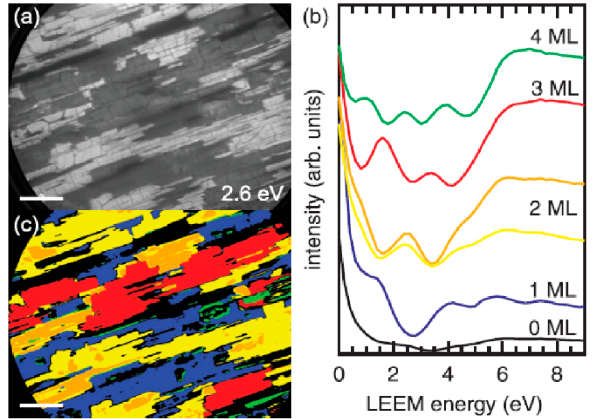
Figure 34. ( a ) LEEM bright-field image at E LEEM = 2.6 eV of graphene on 4H-SiC(1100). ( b ) Typical reflectivity spectra offset from each other for clarity. ( c ) False color image of same area as in ( a ) colored corresponding to the spectra shown in ( b ). The length of the scale bar is 1 µm [144].